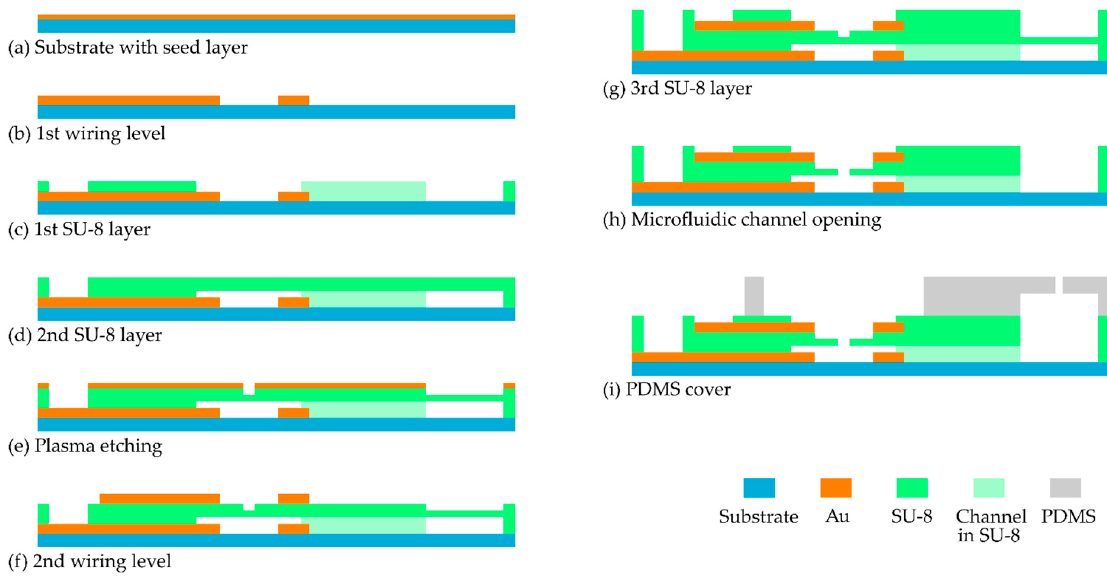
Figure 3. Process flow for the fabrication of the microfluidic chip for EIS measurement of trapped objects under test. ( a ) Deposition of a Ti/Au seed layer. ( b ) Lithography, Au electroplating of 1st wiring level and resist and seed layer strip. ( c ) Lamination and patterning of the 1st SU-8 dry film photoresist (DFR). ( d ) Lamination and lithographic patterning of the 2nd SU-8 DFR. ( e ) Deposition of a Ti/Au seed layer. After the first sub-lithography, the Ti/Au layer is patterned and the 2nd SU-8 DFR is partly dry-etched. ( f ) After the second sub-lithography step, electroplating of Au is carried out for the 2nd wiring level. Etching of seed layer. ( g ) Lamination and patterning of the 3rd SU-8 DFR as a passivation layer. ( h ) Opening of the microchannel. ( i ) Bonding a poly(dimethylsiloxane) (PDMS) cover on the microfluidic chip. Drawings not to scale.